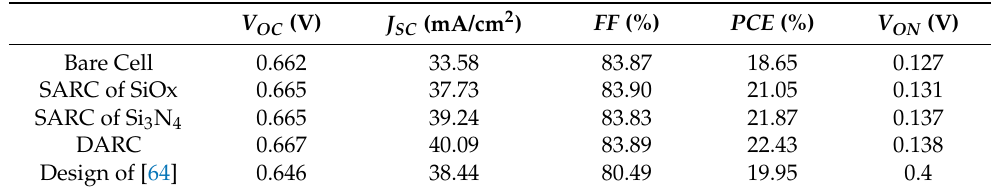
Table 3. Comparison between the associated performance parameters of bare and different coated thin-film c-Si solar cells after enhancement and performance of the initial design. V OC (V) J SC (mA/cm 2 ) FF (%) PCE (%) V ON (V) Bare Cell